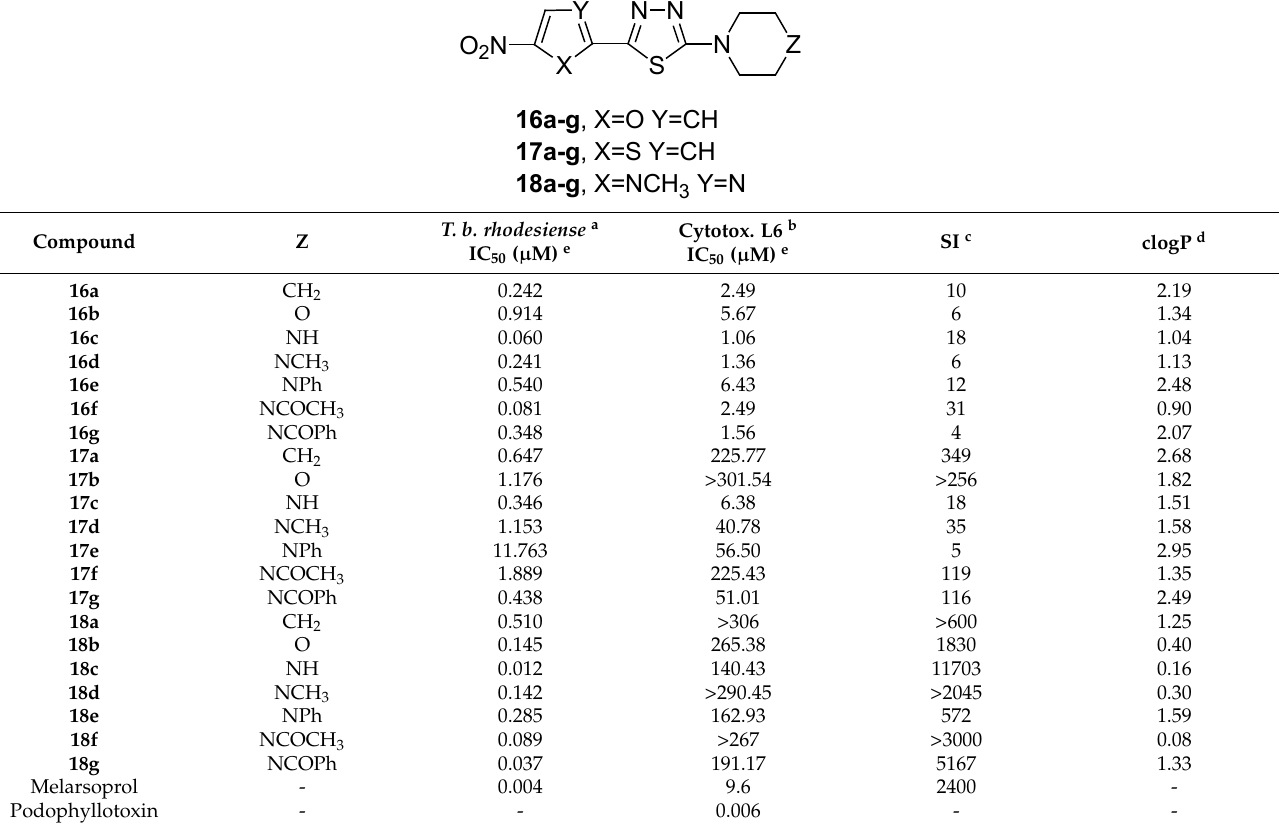
Table 1. Antitrypanosomal activity of the synthesized compounds.